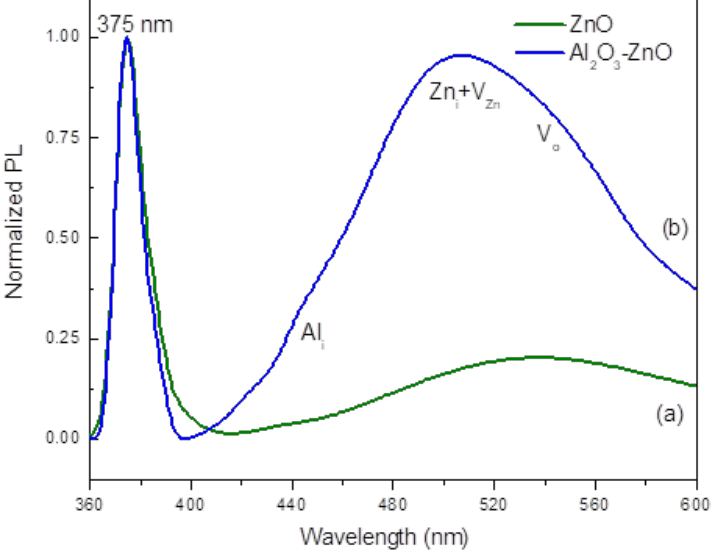
Figure 5. PL spectra of the ( a ) undoped ZnO (green line) and ( b ) Al 2 O 3 -ZnO nanostructures grown by PLD + RFMS (blue line).